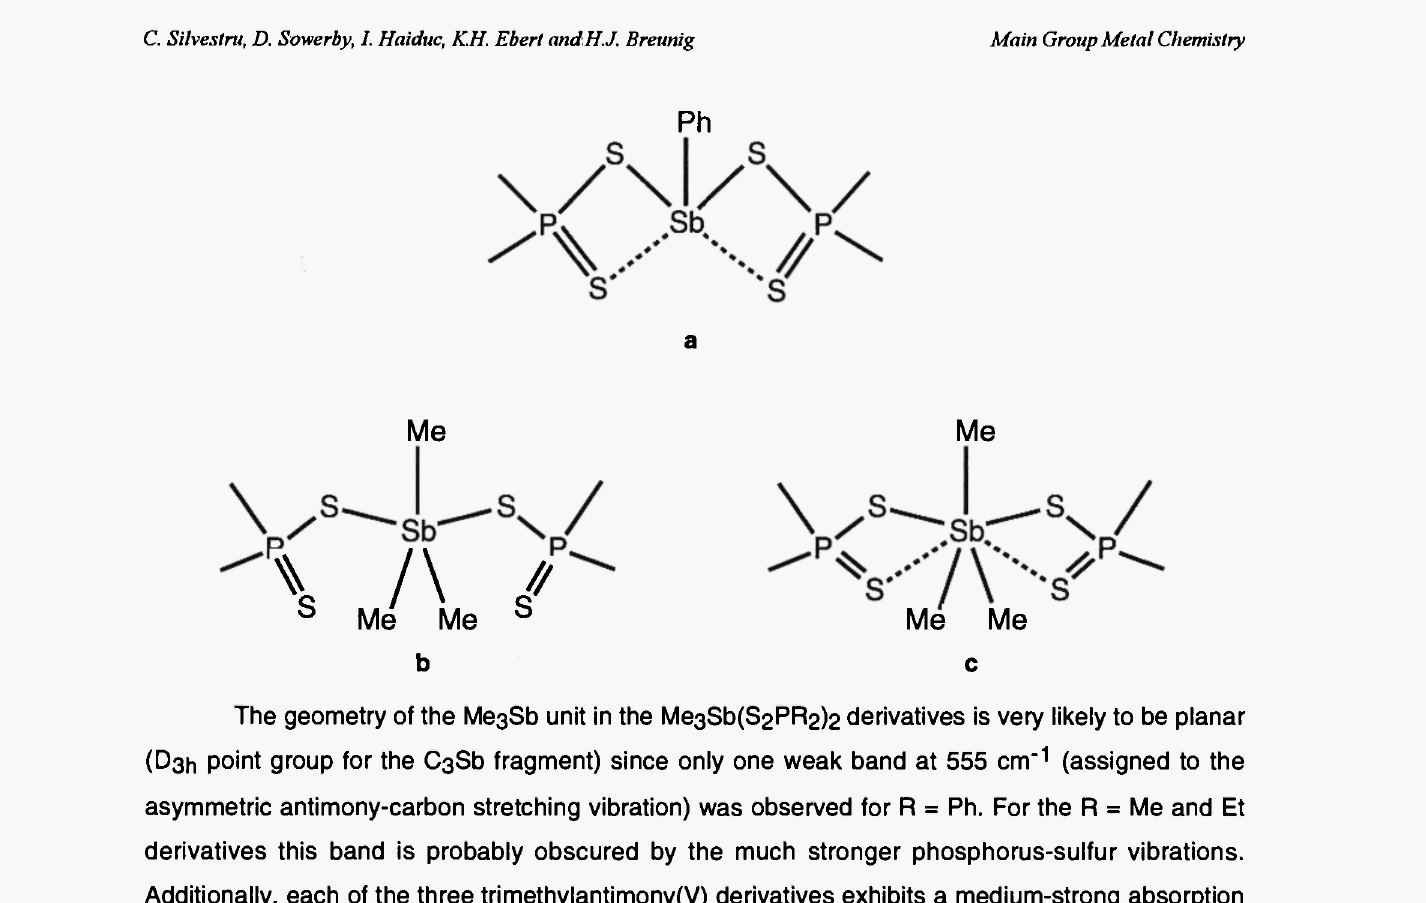
Table 4, and tentative fragmentation patterns are given in Schemes 1 and